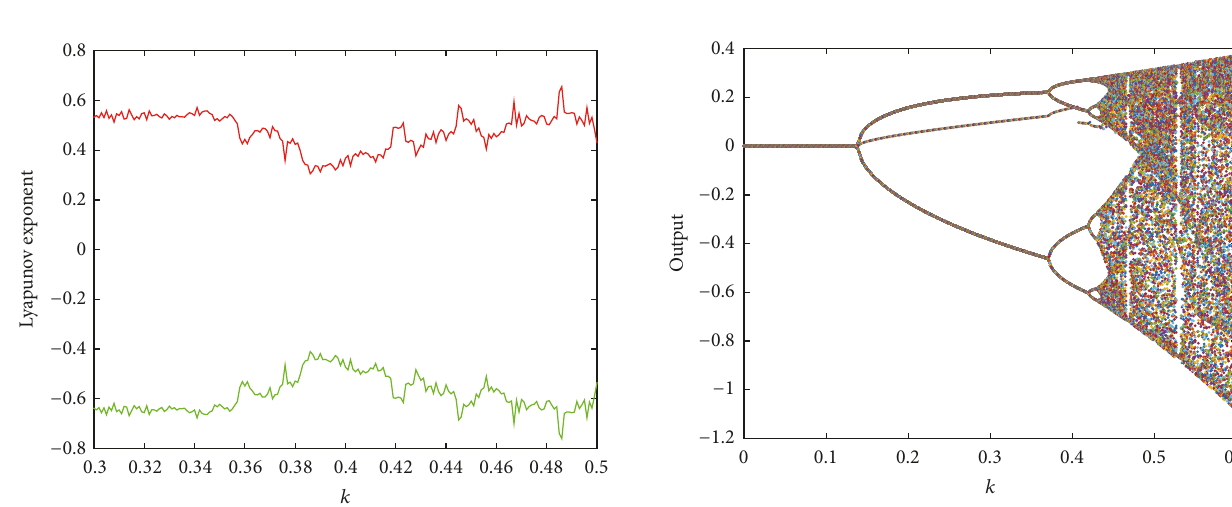
Figure 8: The change of Lyapunov exponents with 𝑘 .